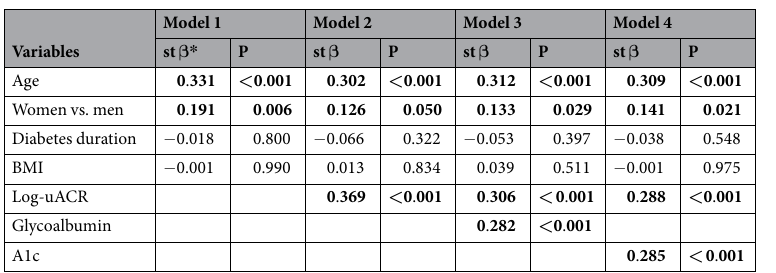
Table 3. Determinants of uNAG excretion level in subjects with type 1 diabetes. * Standardized beta coefficient was calculated to compare the relative contribution of each variable in determining the uNAG excretion level. Covariates included in each model are as follows: Model 1: age, sex, duration of diabetes, BMI; model 2: represent statistically significant values. uNAG and uACR were log-transformed for linear regression models. Abbreviations: A1c, hemoglobin A1c; uNAG, urinary N-acetyl- β -D-glucosaminidase; BMI, body mass index; uACR, urinary albumin-to-creatinine